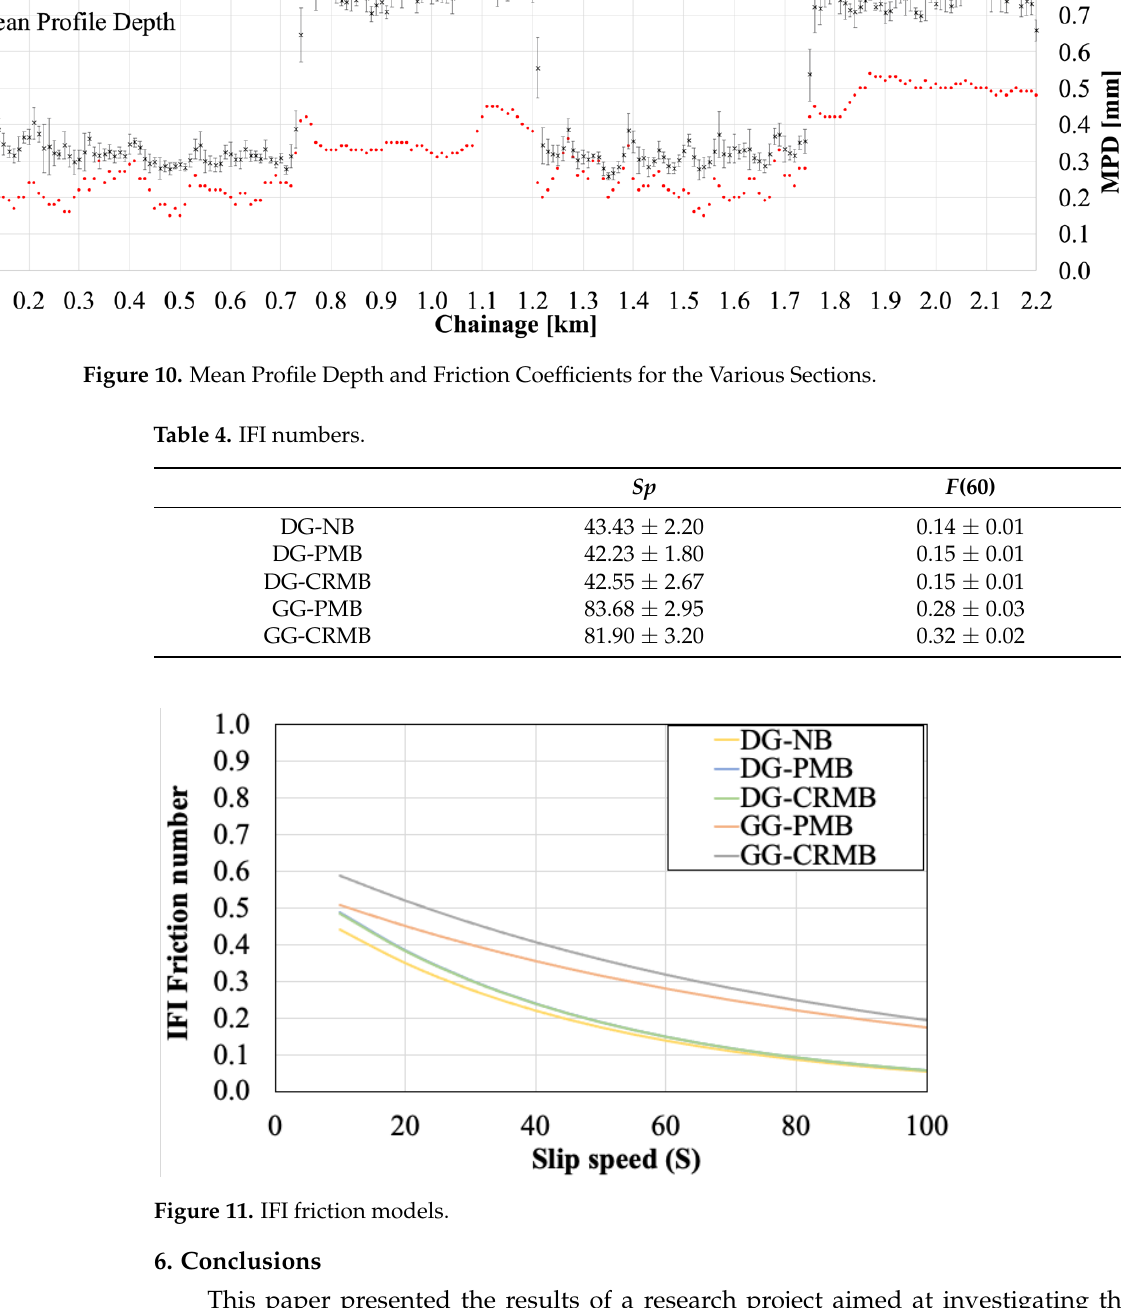
Figure 11. IFI friction models.